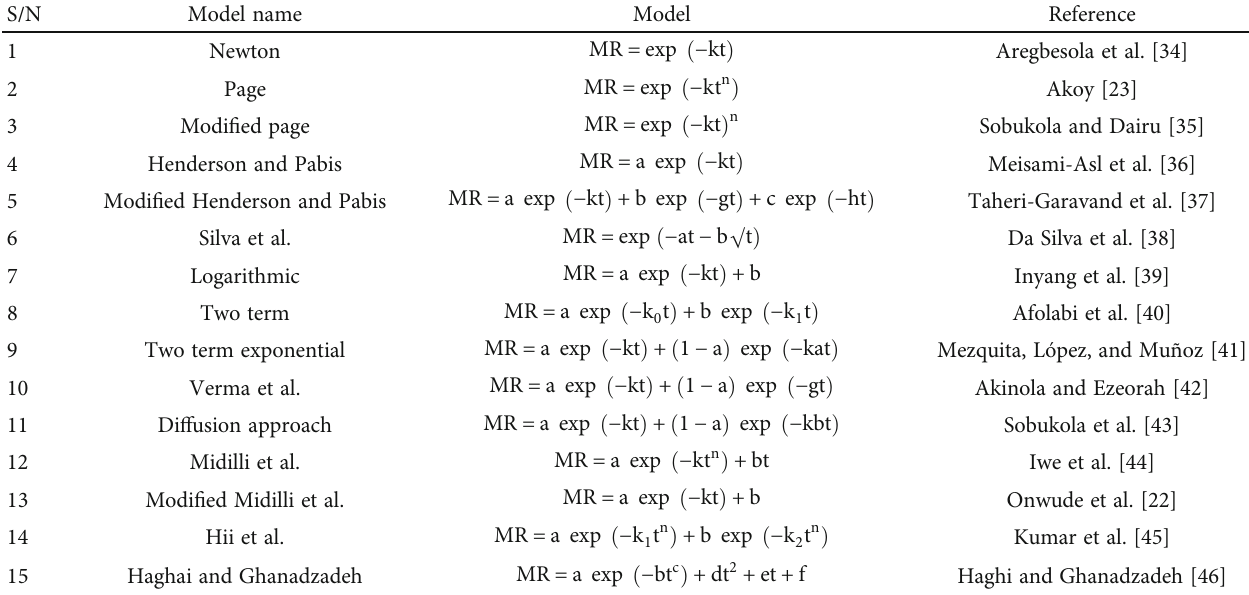
Table 1: Thin layer drying models used in the study.